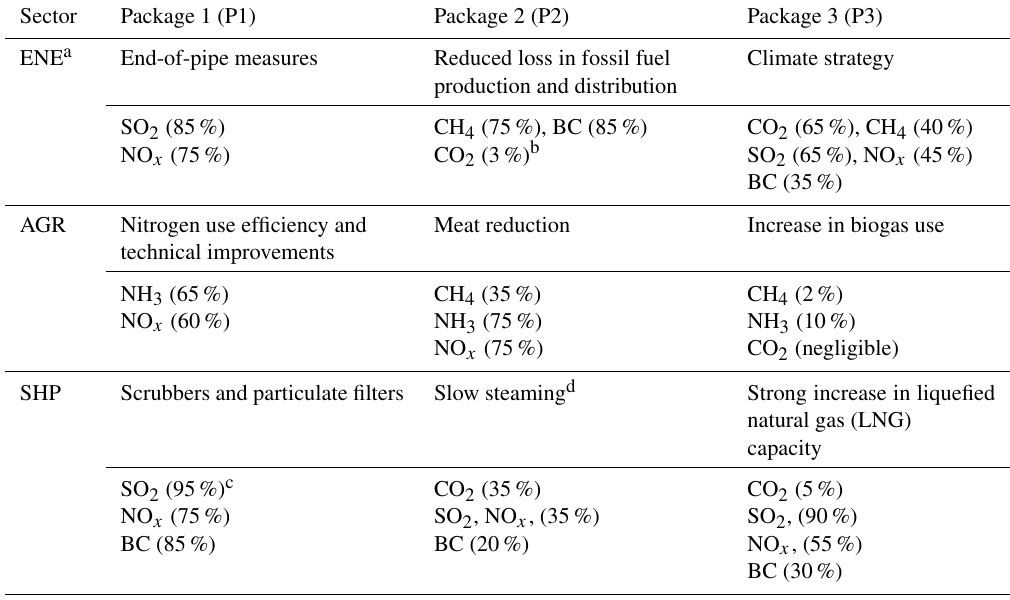
Table 2. Summary of species considered in the idealized emission reduction packages, the percentage reduction assumed, and example polices. All percentages refer the total emissions of a given sector and not total anthropogenic emissions.